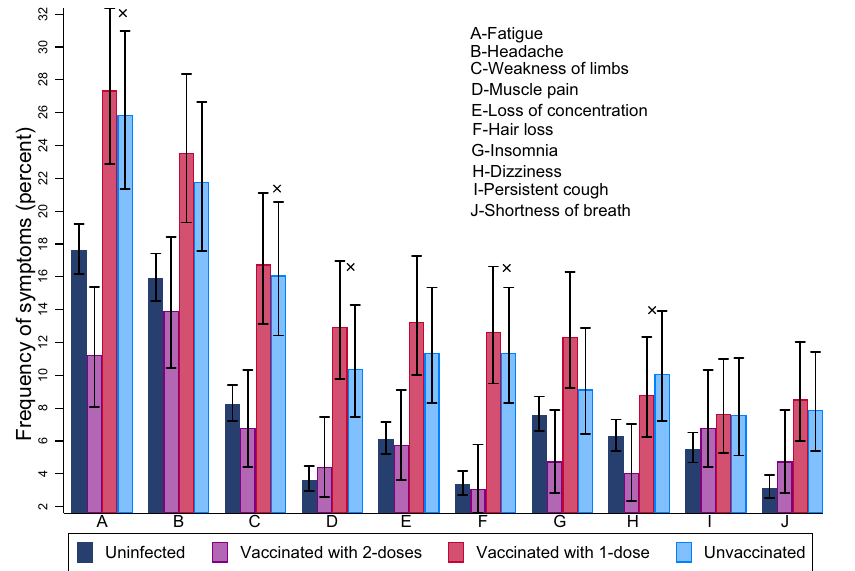
Fig. 1 Frequency of most reported symptoms among the uninfected, the infected and unvaccinated, and the infected and vaccinated with 1 or 2 vaccine doses. Error bars represent 95% con fi dence intervals.